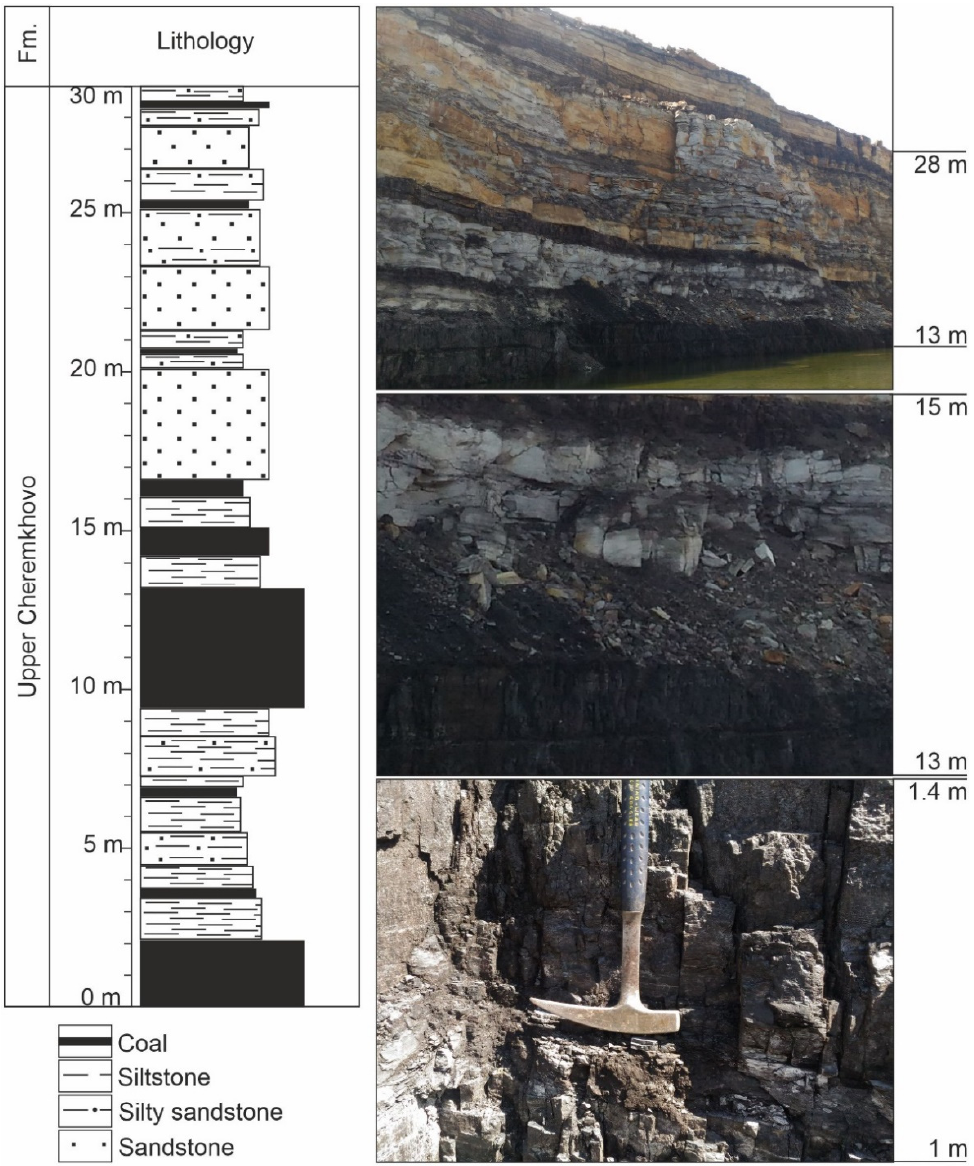
Figure 6. Section of the upper Cheremkhovo Fm. sampling in the area of the Bozoy coal